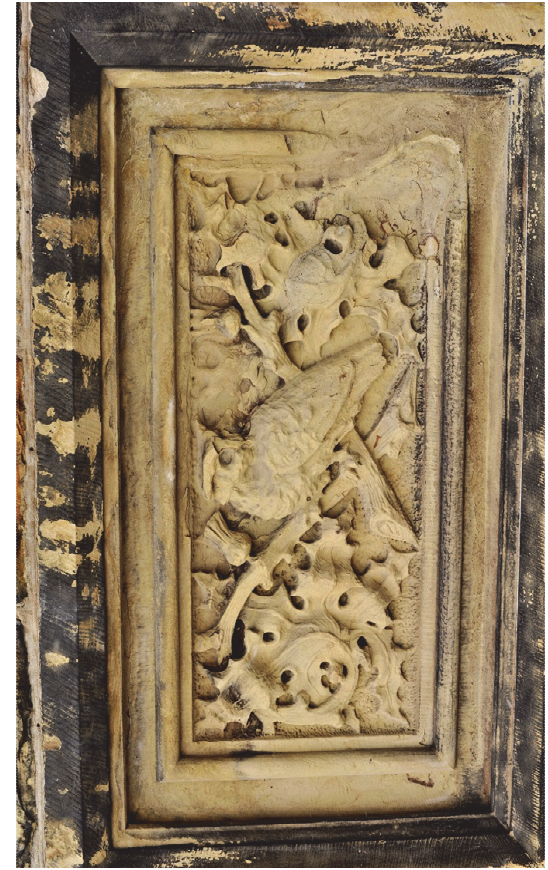
Figure 1. Owl and thistle sandstone relief